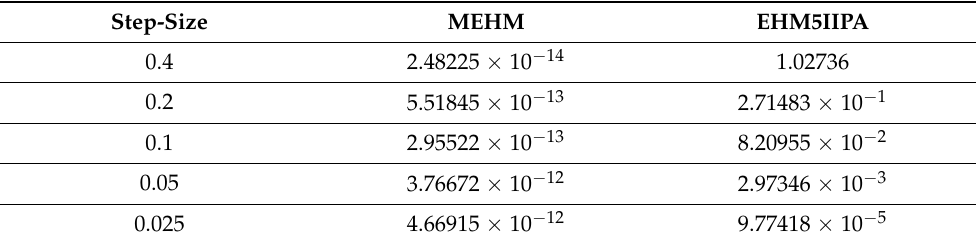
Table 3. Maximum global error in solving Problem